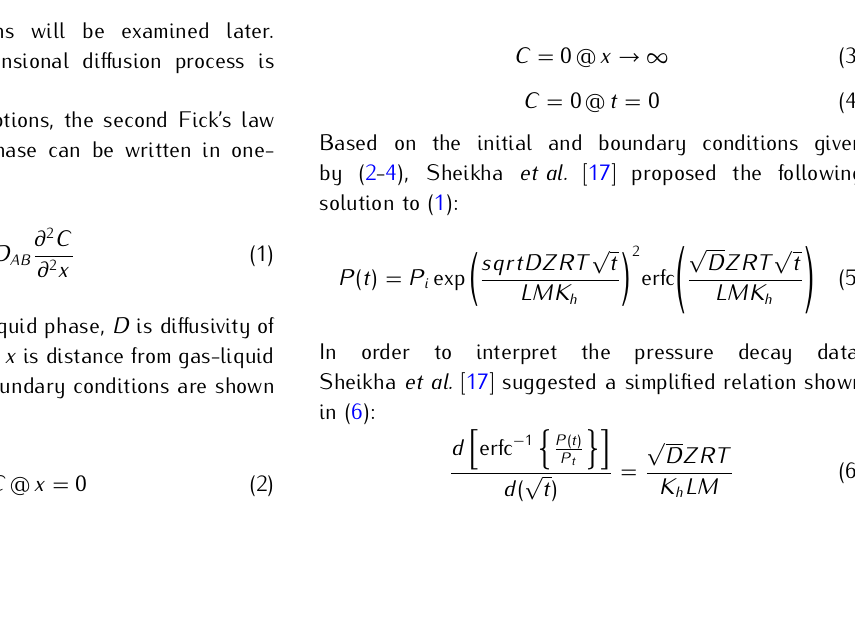
2 diffusion into saline